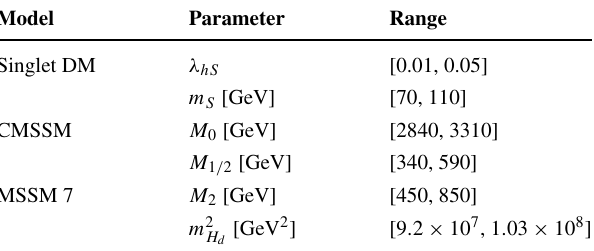
Table 10 Ranges that parameters are varied over in Fig. 6. All of the parameters of the MSSM 7 are defined at an energy scale of 1 TeV